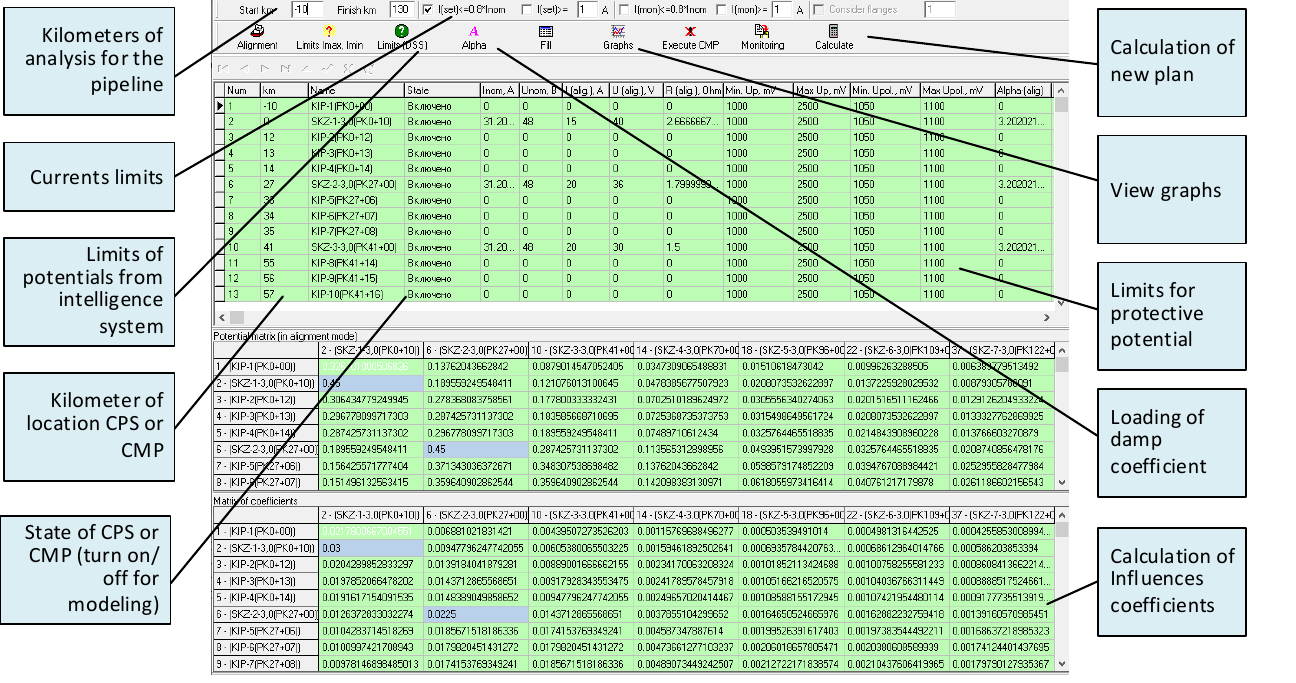
Figure 7. The main window of the adaptive intelligent system for monitoring and managing the protective parameters of the CPS.